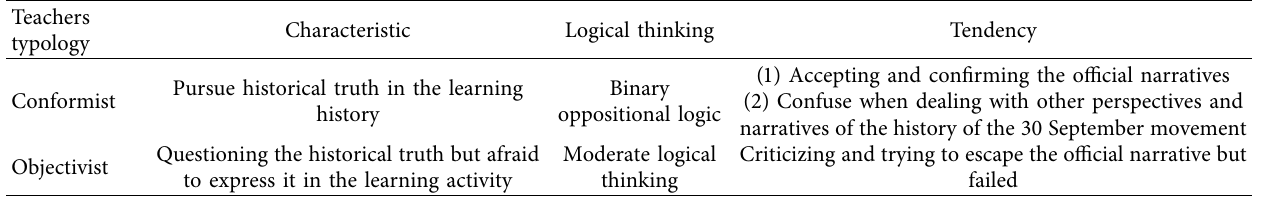
Table 2: Typology of history teachers in dealing with the history of the 30 September